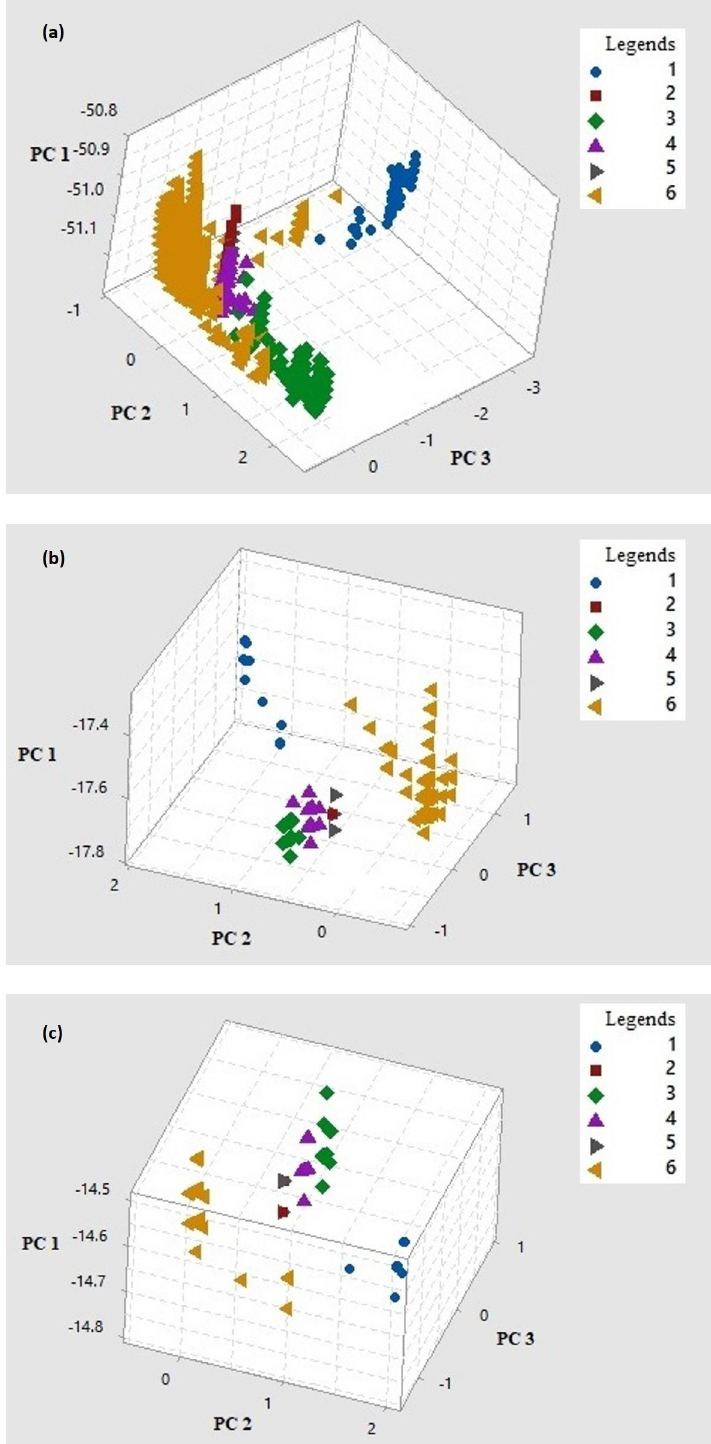
Figure 4. Cluster plots generated using Principal Component Analysis (PCA) of SARS-CoV-2: complete genome data ( a ); spike gene ( b ) and RdRp gene ( c ) for VoCs and VoIs designated as 1 (Alpha), 2 (Beta), 3 (Delta), 4 (Kappa), 5 (Eta), and 6 (Others). A genome-based PCA scatter plot generated for the first three PCs (accounting for 99.71% variance) revealed three major clusters, wherein Alpha (1) clustered independently. Delta (3) and Kappa (4) formed clusters next to the clusters formed by Beta (2), Eta (5), and Others (6). A few members of Alpha (1) and Others (6) are away from their